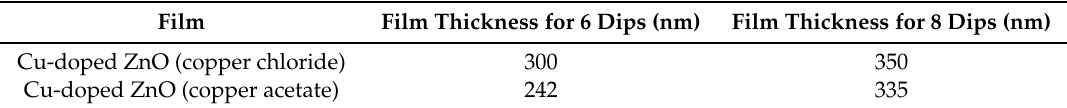
Table 2. Number of dips and corresponding film thicknesses.